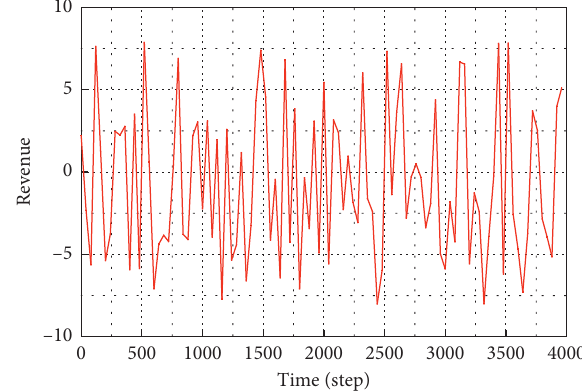
Figure 5: Time series of earnings.